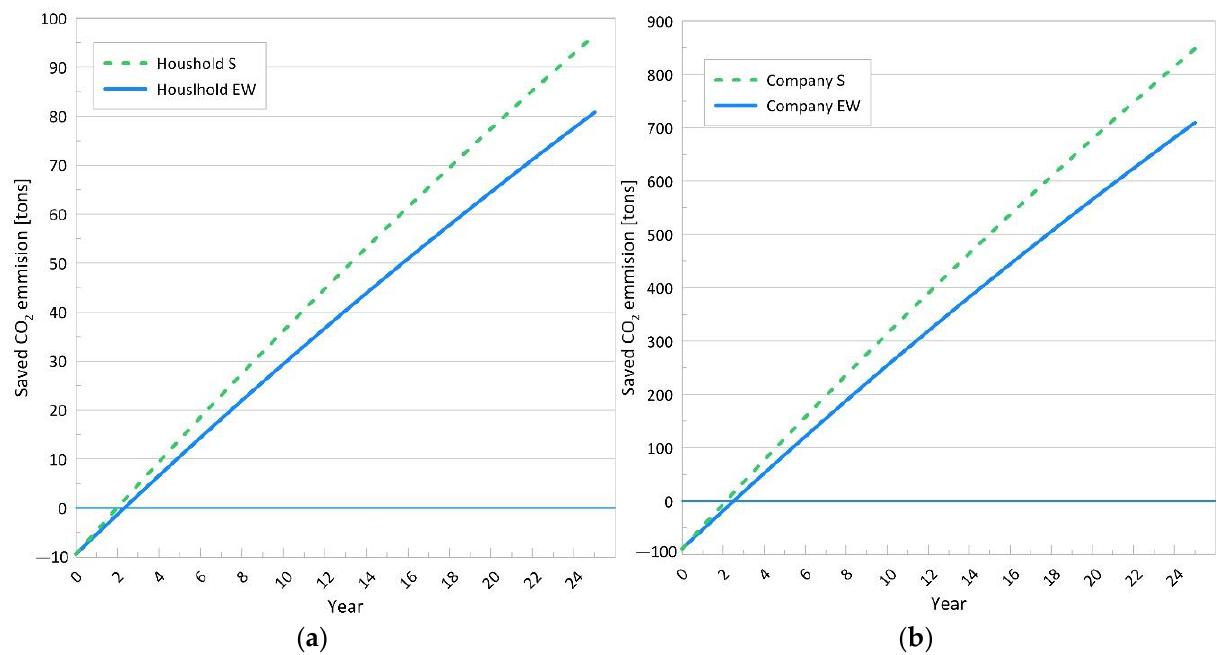
Figure 5. Cumulative CO 2 emission reduction during 25 years of PV system operation ( a ) for the household and ( b ) for the company.